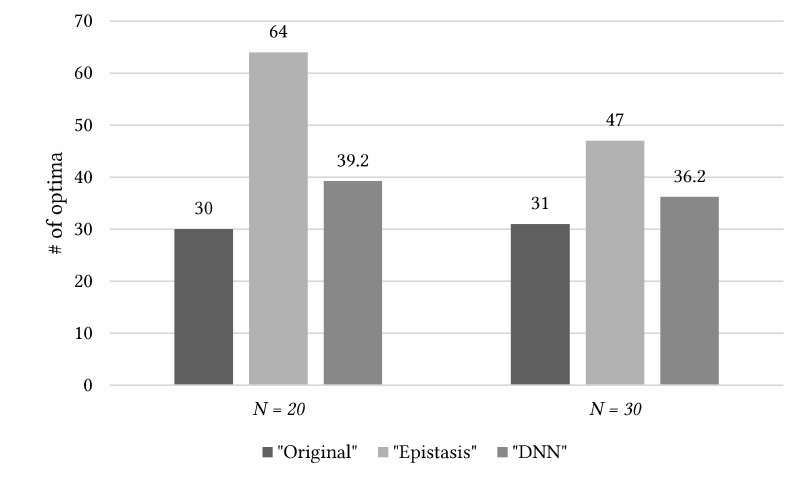
Figure 4. Performance comparison of the experiment in this study (“DNN”) and those in previous studies (“Original” and “Epistasis”) on the Variant-OneMax problem